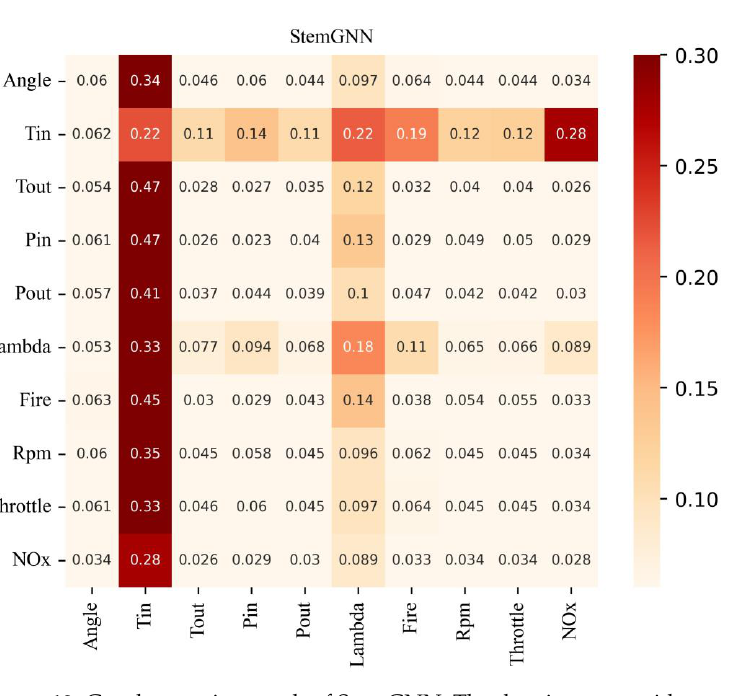
Figure 10. Graph attention result of StemGNN. The data in every grid represent the attention score of the variable to another variable.